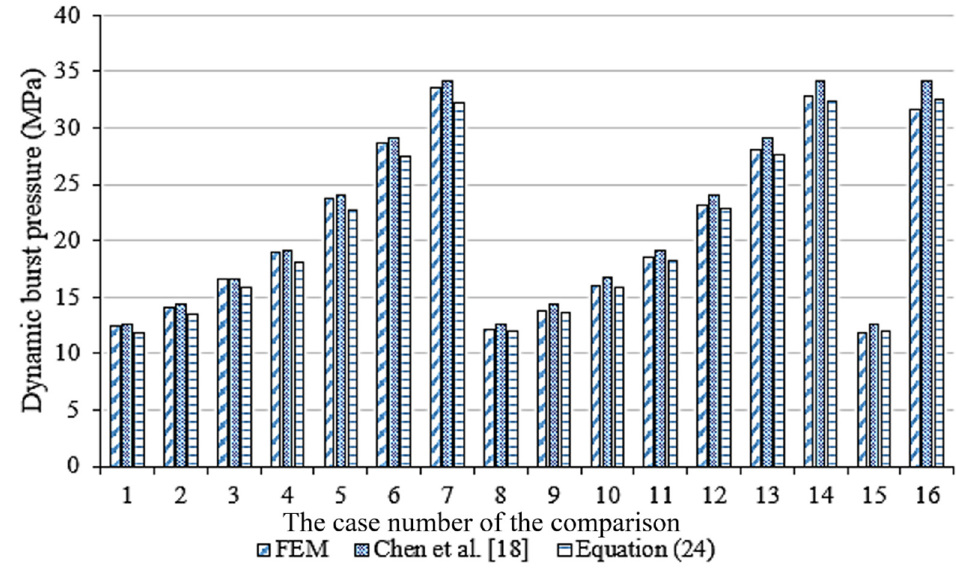
Figure 9. Comparisons between the FEM results and Equation (24), when t d = 3.9 ms.